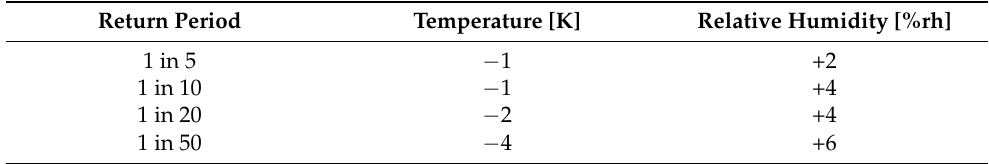
Table 6. Different return periods with corrections to temperature and relative